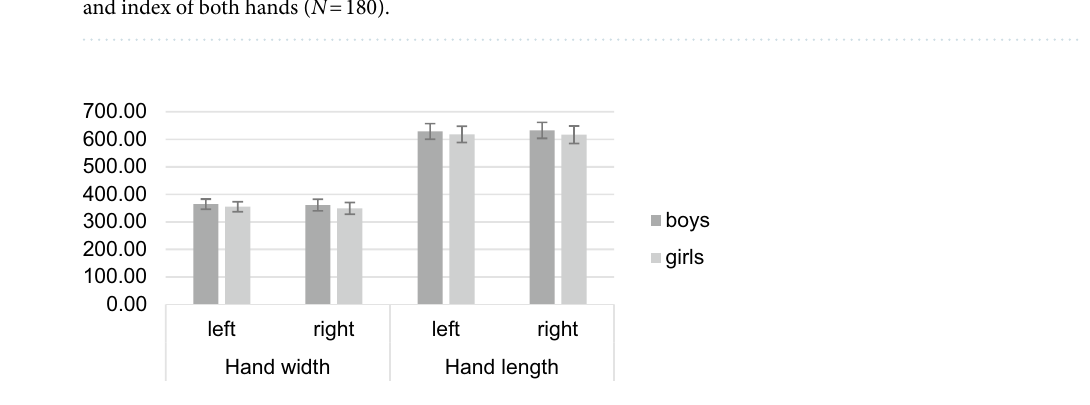
Figure 5. Means and standard deviations in right, left, and averaged hand width and length separately for boys and girls.